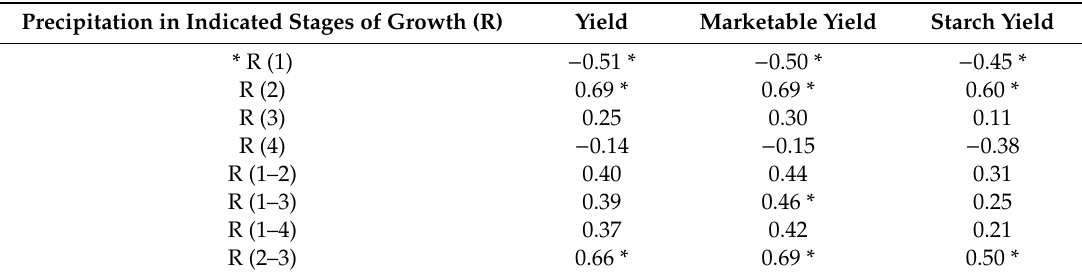
Table 4. Spearman correlation coe ffi cients between yield elements and the total precipitation in various stages of potato development.